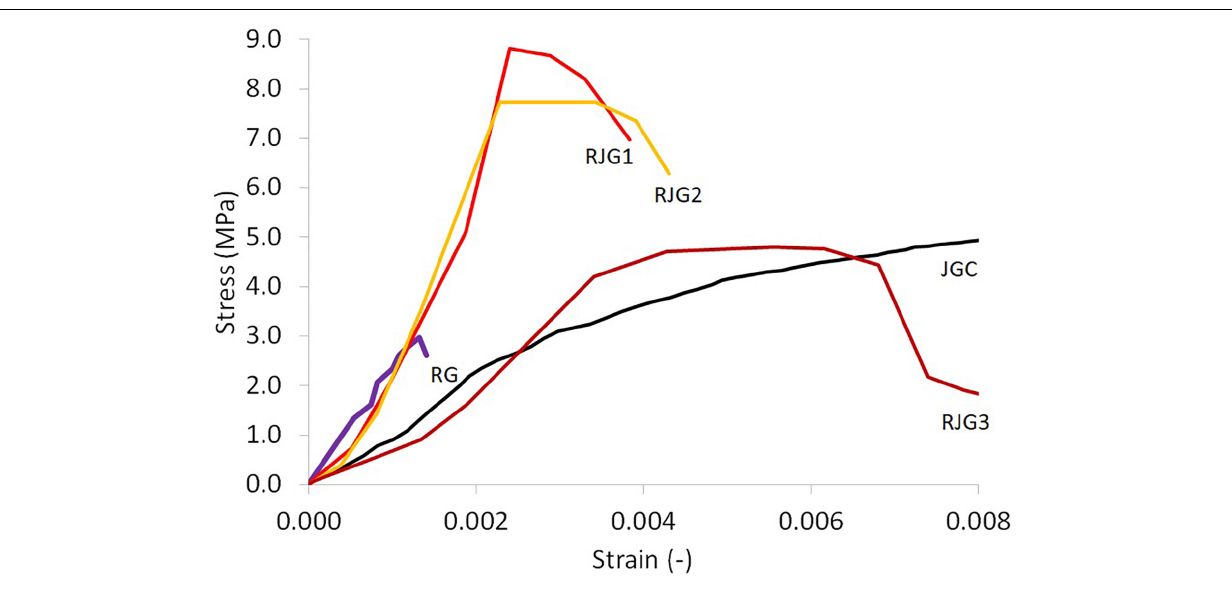
( Figure 4 ). As the fiber diameter decreases, the surface area increases, thereby favoring the wettability of fibers within the geopolymer